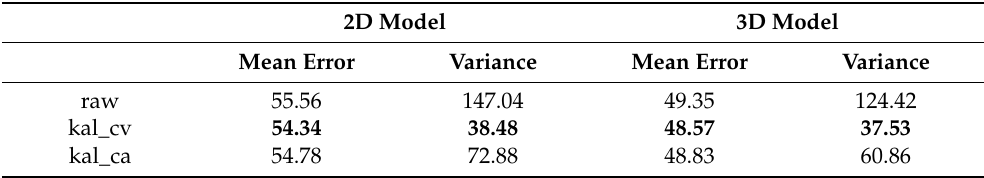
Table 4. Mean and variance of all